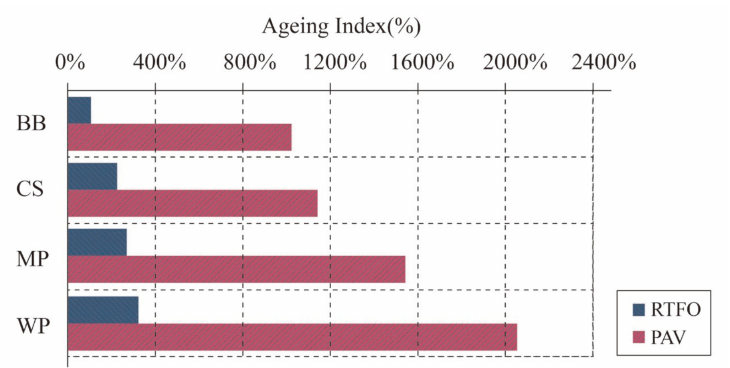
Figure 5. Ageing index for complex modulus of RTFO-aged and PAV-aged bio-oil modified asphalts at 64 ◦ C and 10 rad/s [8]. Note: BB refers to swine manure-based bio-asphalt; CS refers to corn stover-based bio-asphalt; MP refers to miscanthus pellets-based bio-asphalt; WP refers to wood pellets-based